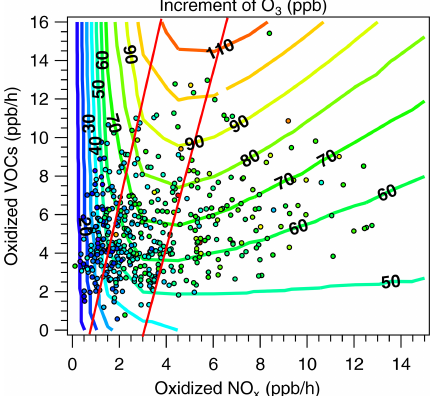
Figure 8. Ozone isopleths (in ppbv) of traditional 2D-EKMA plot for the two episodes calculated by the box model are shown in col- ored lines, ozone concentrations at 13:00LT derived by the OBM are shown in colored dots, and the x axis and y axis are hourly oxi- dized NO x and oxidized VOC,